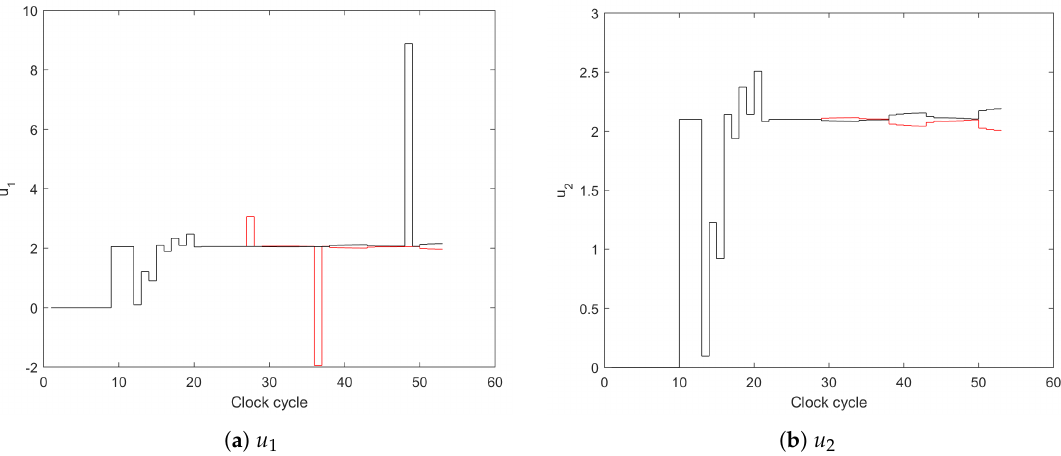
Figure 5. Matlab simulation example. Clock cycle accurate simulations of two CFLED enhanced 2-DOF units connected in reaction, and denoted with colors red and black,